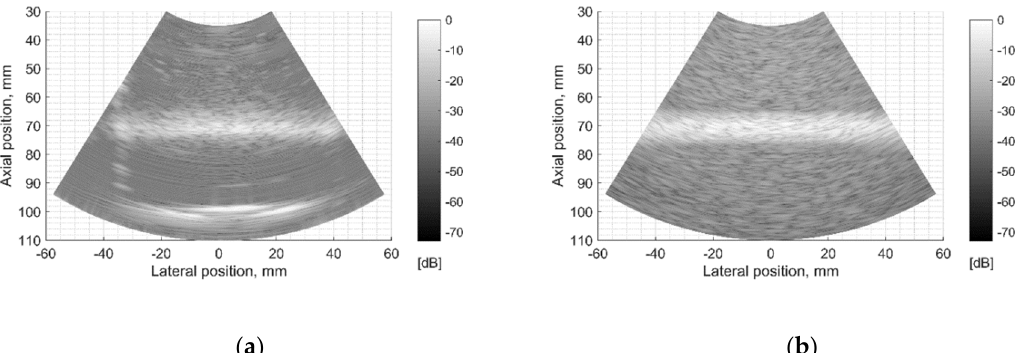
Figure 8. Comparison of slice thickness (elevation resolution) in B-scan images of ( a ) physical Model 538NH phantom and ( b ) digital inclined plane phantom.